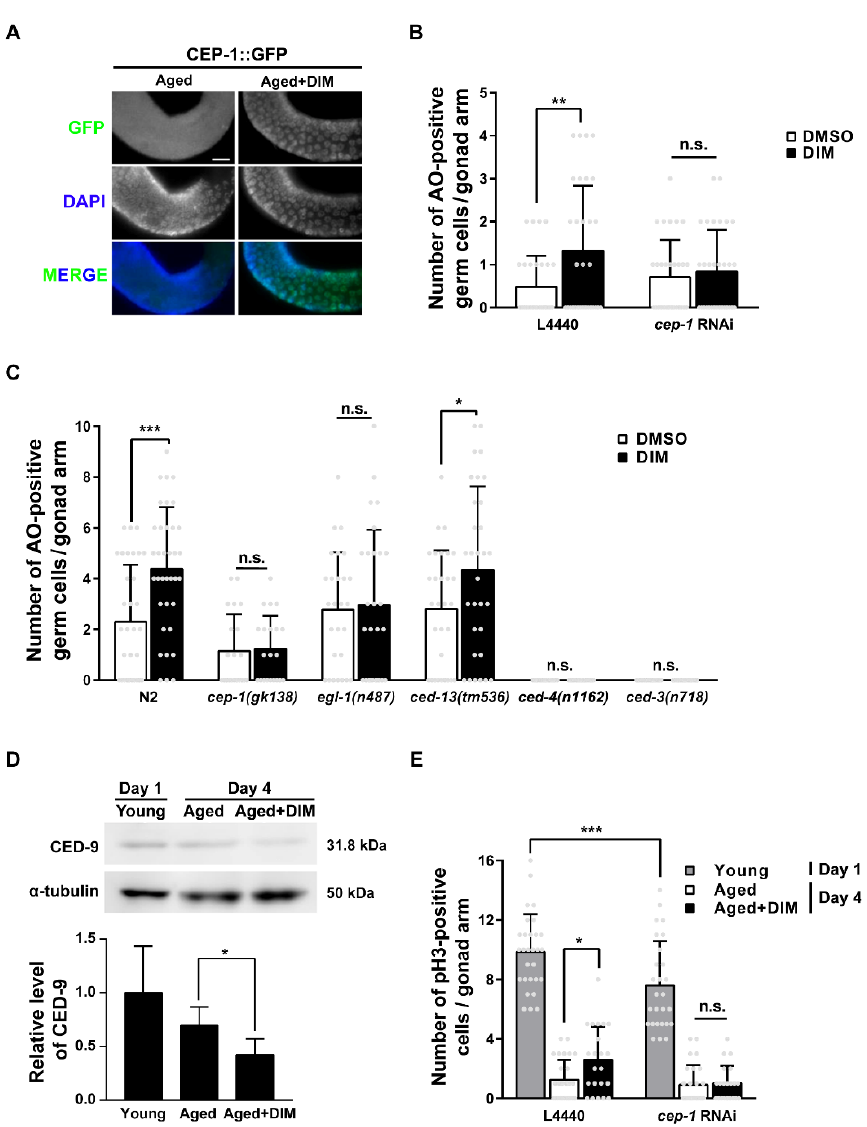
Figure 6. The germ cell apoptosis and germ cell proliferation induced by DIM supplementation were dependent on germline CEP ‐ 1 activity in reproductively aged Caenorhabditis elegans : ( A ) Representative images of the CEP ‐ 1 (green) in the late pachytene region were shown using anti ‐ GFP immunostaining in CEP ‐ 1::GFP transgenic animals supplemented with DMSO (Aged, n = 28) or DIM (Aged+DIM, n = 27) at the day 3 adult stage for 24 h. ( B ) The graph indicates average numbers of AO ‐ positive germ cells per gonad arm using AO staining in the knockdown of cep ‐ 1 in the germ line (each condition, n = 31) of day 4 adults. The synchronized L4 ‐ staged DCL569 (germline ‐ specific RNAi) strains were transferred to L4440 or cep ‐ 1 feeding RNAi plate for 24 h, then transferred to the NGM plate. The day 3 adult worms were supplemented with DMSO or DIM for 24 h. Error bars represent SD. n.s., not significant., **, p < 0.01 (two ‐ way ANOVA with Tukey’s post ‐ hoc test). ( C ) The graph indicates average numbers of AO ‐ positive germ cells per gonad arm using AO staining shown in the adult wild ‐ type N2, cep ‐ 1(gk138), egl ‐ 1(n487), and ced ‐ 13(tm536), ced ‐ 4(n1162), ced ‐ 3(n718) mutants supplemented with DMSO or DIM at the day 3 adult stage for 24 h. (Each condition, n > 22). Error bars represent SD. n.s., not significant., *, p < 0.05, ***, p < 0.001 (two ‐ way ANOVA with Sidak’s multiple comparisons test). ( D ) Representative images and a quantification graph indicate western blot analysis of CED ‐ 9 in young ( n = 300), aged ( n = 300), and aged+DIM ( n = 300). The expression level of CED ‐ 9 was normalized to that of α‐ tubulin (loading control) on the same lane, and the relative level of CED ‐ 9 was converted to a relative value against that of Day 1 as 1. Error bars represent SD. *, p < 0.05 (two ‐ way ANOVA with Tukey’s post ‐ hoc test). ( E ) The graph indicates